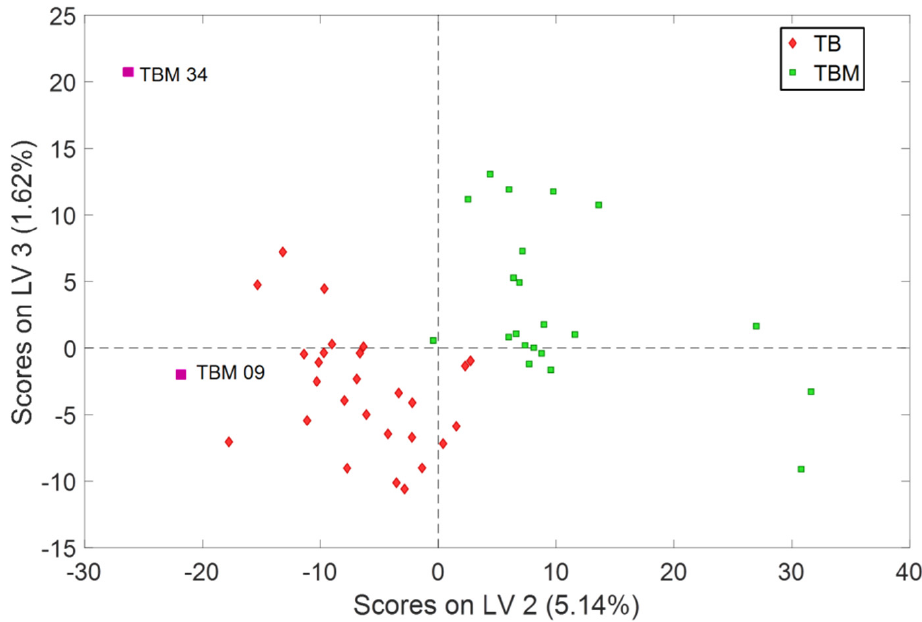
Figure 4. Exploratory analysis: partial least squares (PLS) score plots of white Tequilas fused data (TB: ‘100% agave’, and TBM: ‘mixed’).